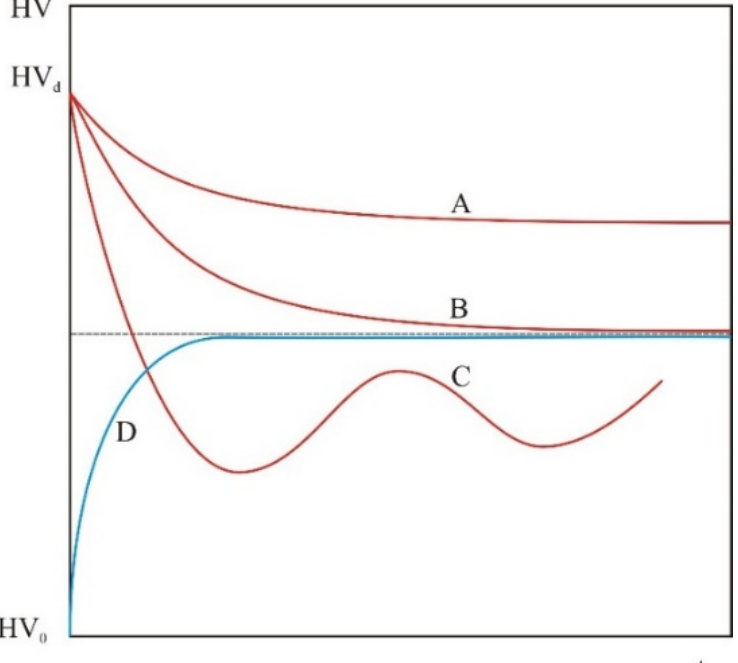
Figure 9. Time dependencies of microhardness of annealed and deformed samples during UST with different amplitudes of the stress: A, B, C—initially deformed state; D—initially annealed state; σ m 1 < σ mA < σ mB < σ m 2 < σ mC ; the meanings of designations are explained in the text [58].